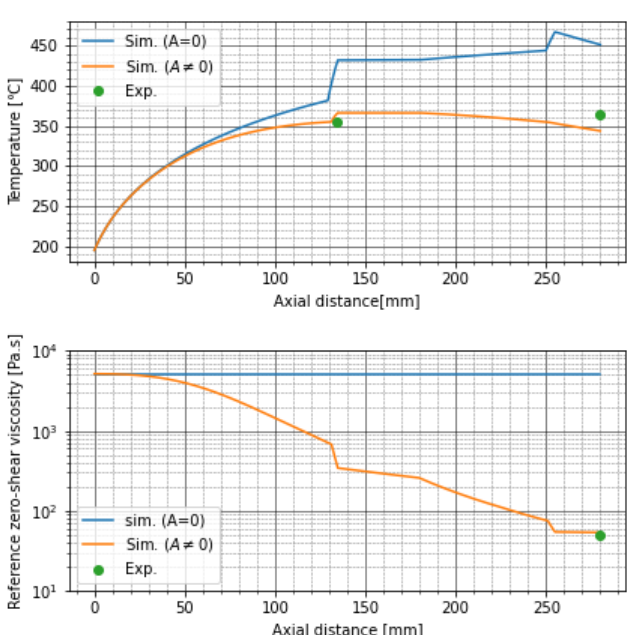
Figure 12. Comparison of simulation results and experimental results in experiment 1 when screw rotational speed was 3600 min − 1